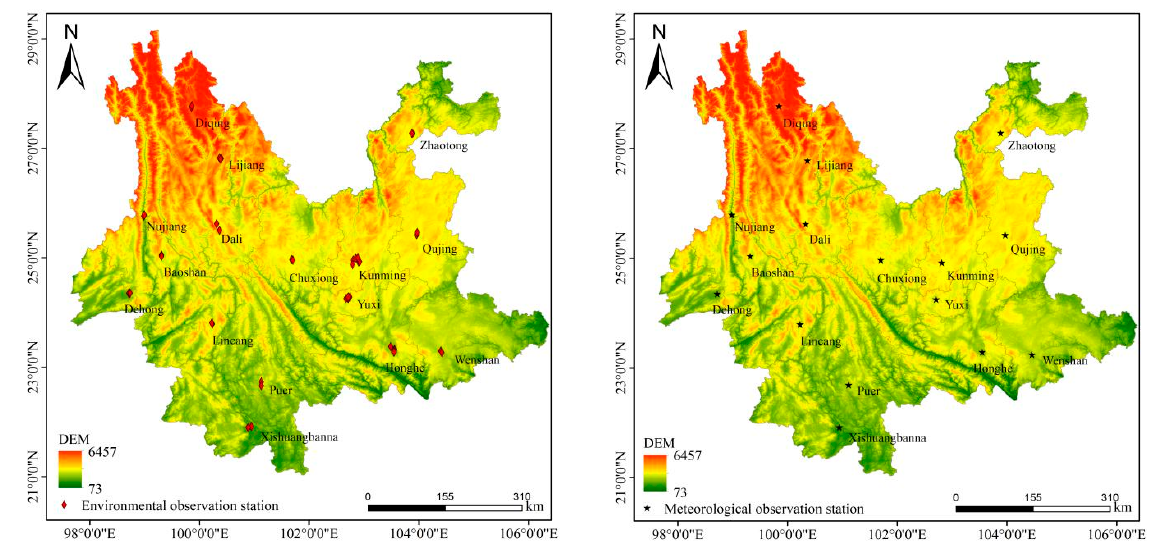
Figure 1. Spatial distribution of 46 O 3 stations and 16 meteorological observation stations in Yunnan Province.